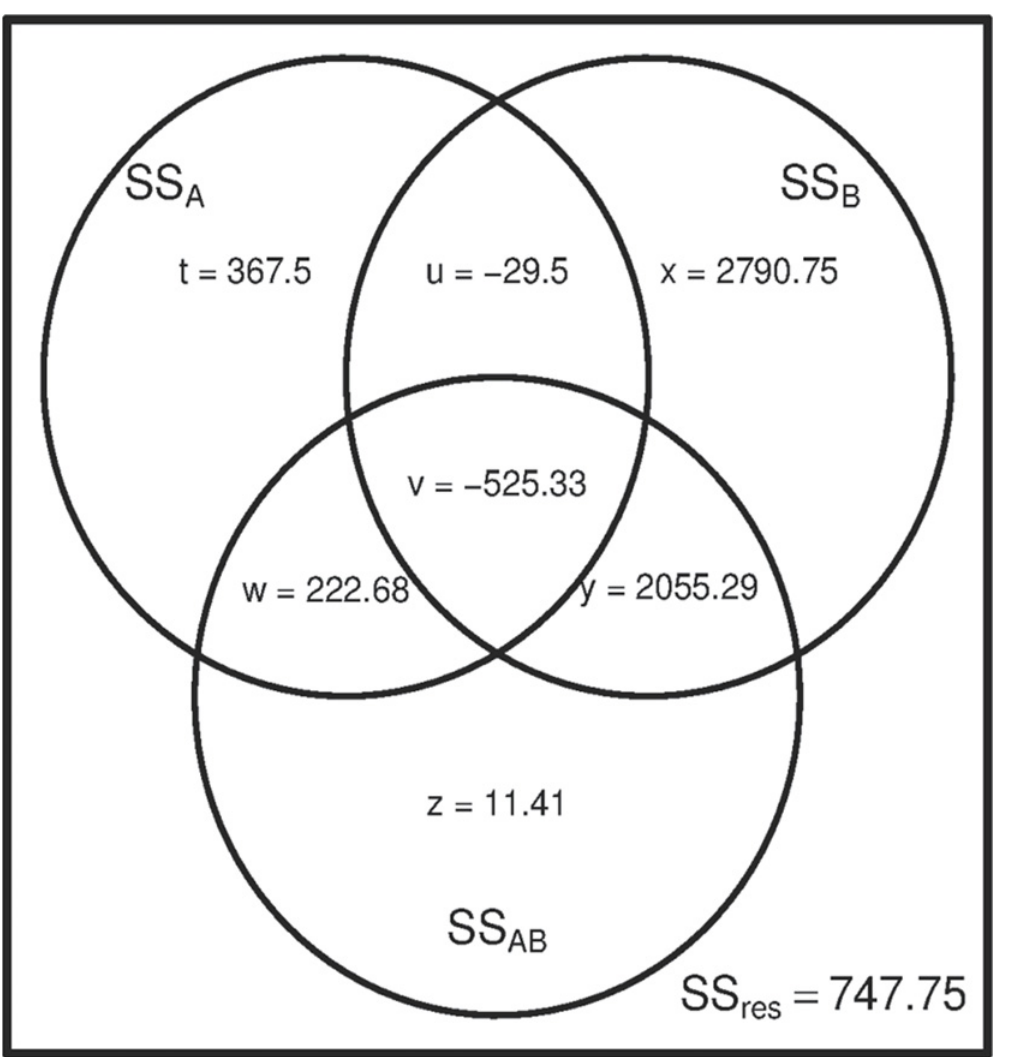
Fig 1. Venn diagram of the example data [13], using treatment coding (0,